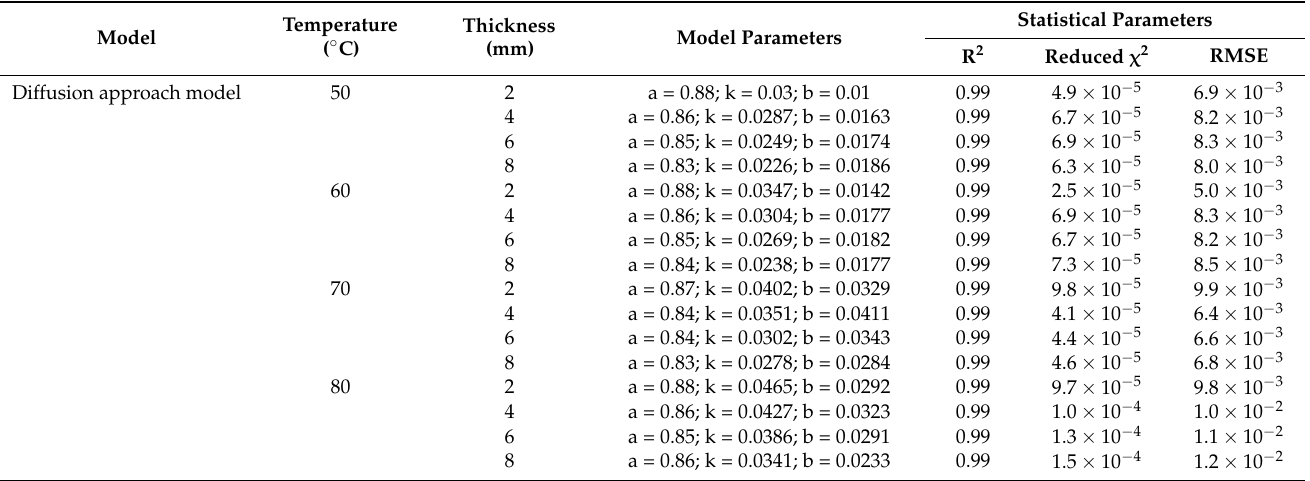
Table 2. Diffusion approach model constant and coefficients at different drying temperatures and thickness with statistical performance indicators (better fit